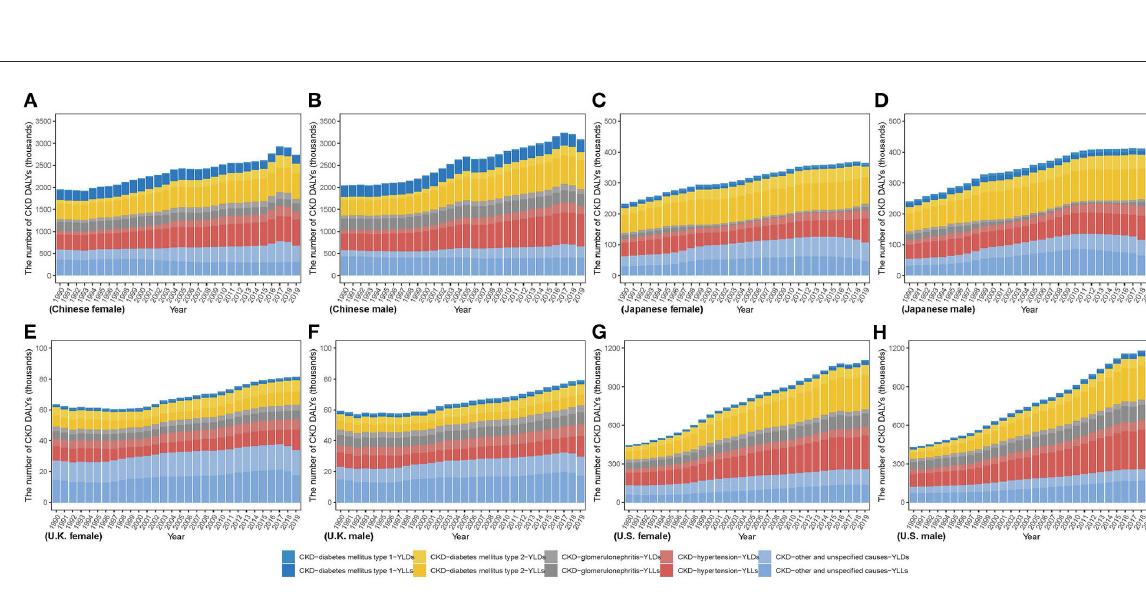
FrontiersinPublicHealth 06